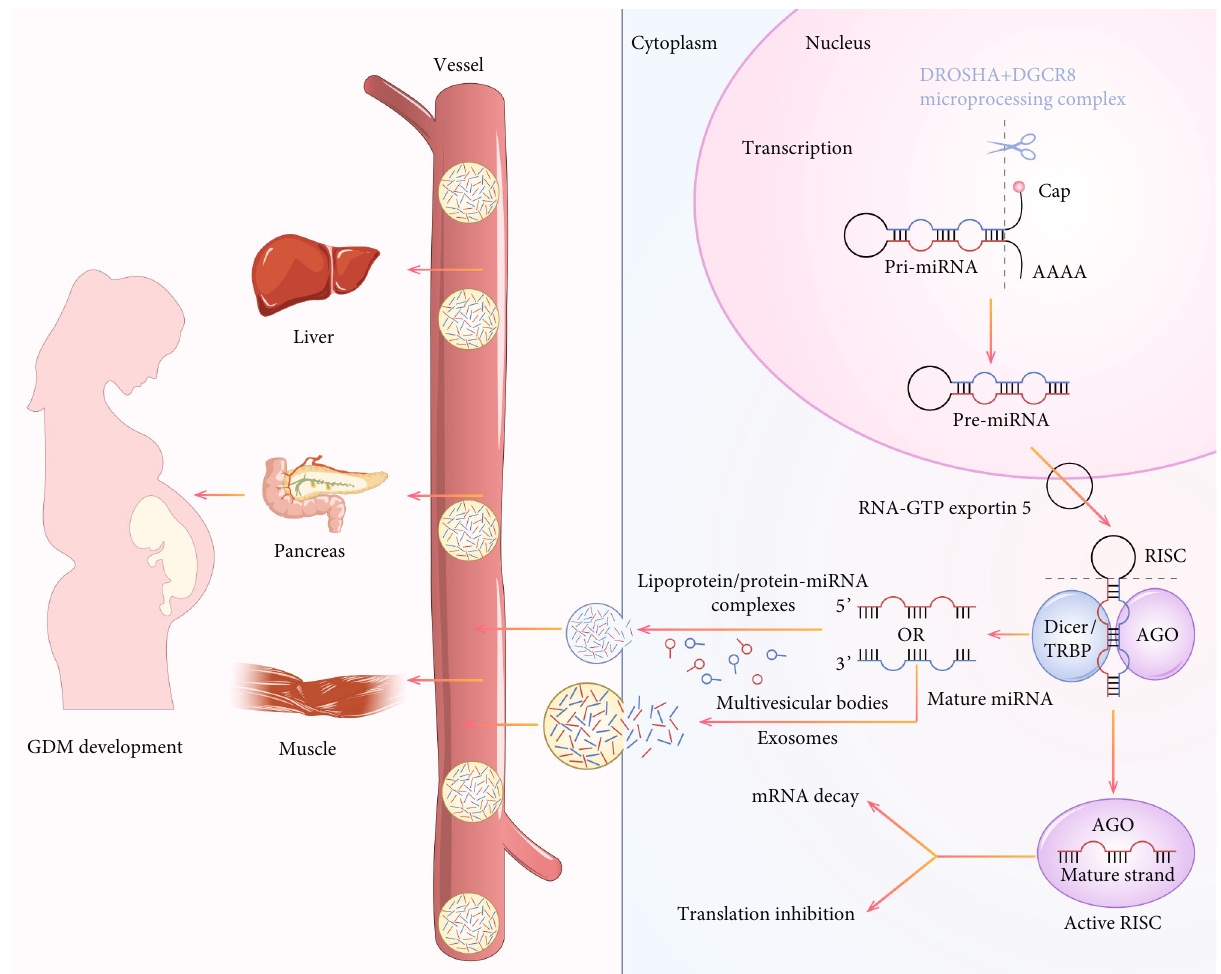
Figure 1: Overview of the biogenesis and potential functions of miRNAs in GDM. The biogenesis pathway for miRNAs is shown on the right side: pri-miRNA is cropped by the microprocessor complex to produce a pre-miRNA, which is then exported to the cytoplasm by the Exportin5-RanGTP system. The Dicer/TRBP complex cleaves the terminal loop of the pre-miRNA to create a miRNA duplex [21]. The latter is loaded into the RISC and further unwinds in the Argonaute (AGO) protein, the center of RISC [21, 22]. During this process, the guide RNA strand from the miRNA duplex is selected as the mature miRNA, while the other passenger RNA strand is degraded. This guide strand remains in the RISC to form the miRNA-RISC complex as an essential component [23], serving to play a role in mRNA decay or translation inhibition [13, 24 – 28]. Furthermore, miRNA is exported to the extracellular space through various carriers such as lipoproteins, proteins, and exosomes [34]. The participation of miRNA in the pathogenesis of GDM is shown on the left: these miRNA complexes are transported in the vessel and exert their potential functions on the pathogenesis of GDM through tissues/ organs that linked to glucose metabolism (e.g., liver, pancreas, and muscle), serving as diagnostic biomarkers and therapeutic target in